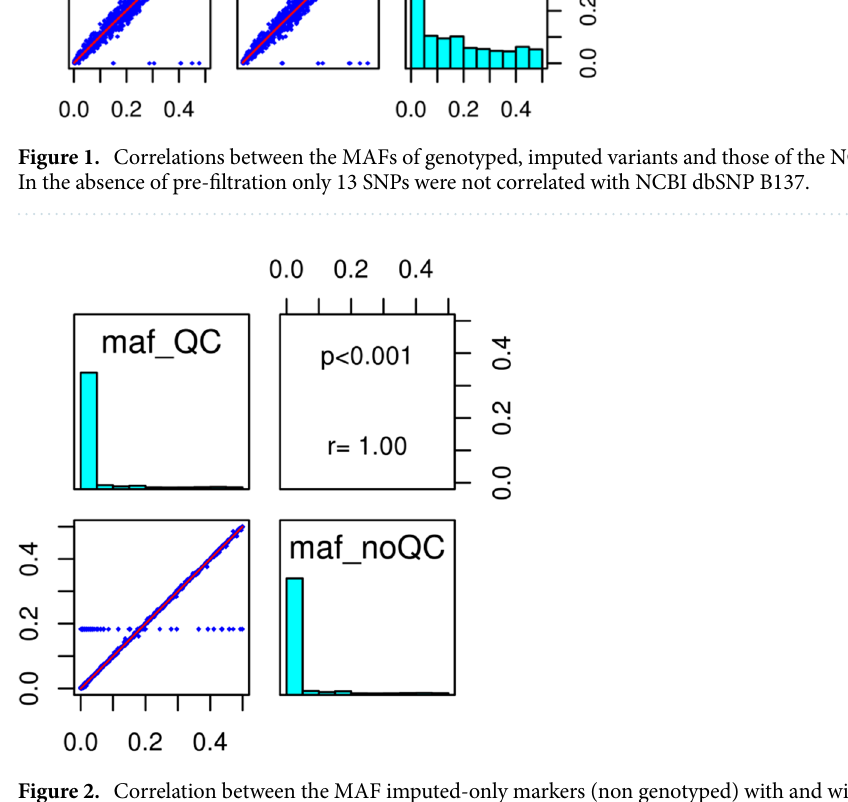
Figure 2. Correlation between the MAF imputed-only markers (non genotyped) with and without QC pre- filtration (44 unreliable structural variants included 12 monomorphic variants reported in dbSNP B137; 29 absent from dbSNP B137 and 3 with discordant alleles compared to